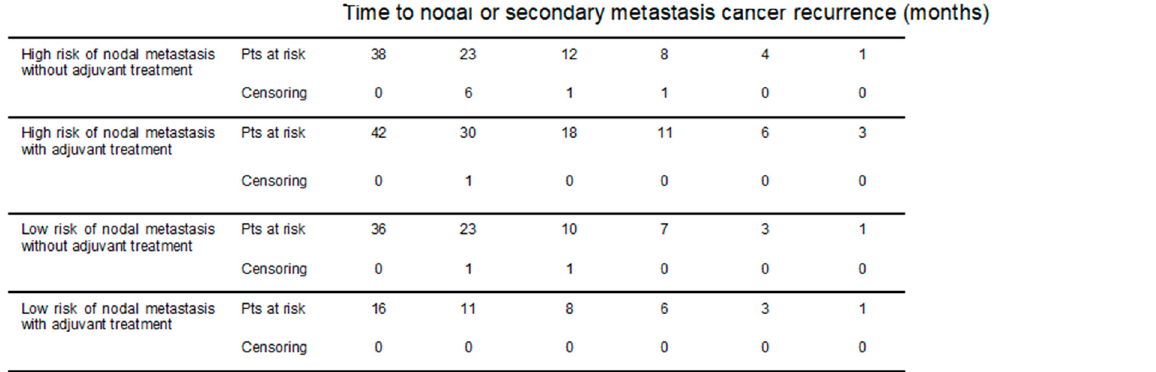
Figure 4. Metastatic recurrence-free survival rates in patients at low or high risk of nodal or distal metastasis with and without adjuvant chemoradiotherapy and/or surgery. SCC, squamous cell carcinoma. Low risk of nodal and distal metastasis was defined as an infiltration depth of ≤ Sm1, with no lymphovascular invasion and well differentiated. A high risk of nodal and/or distal metastasis was defined as an infiltration depth of ≥ Sm2, positive lymphovascular invasion, or mildly and poorly differentiated.